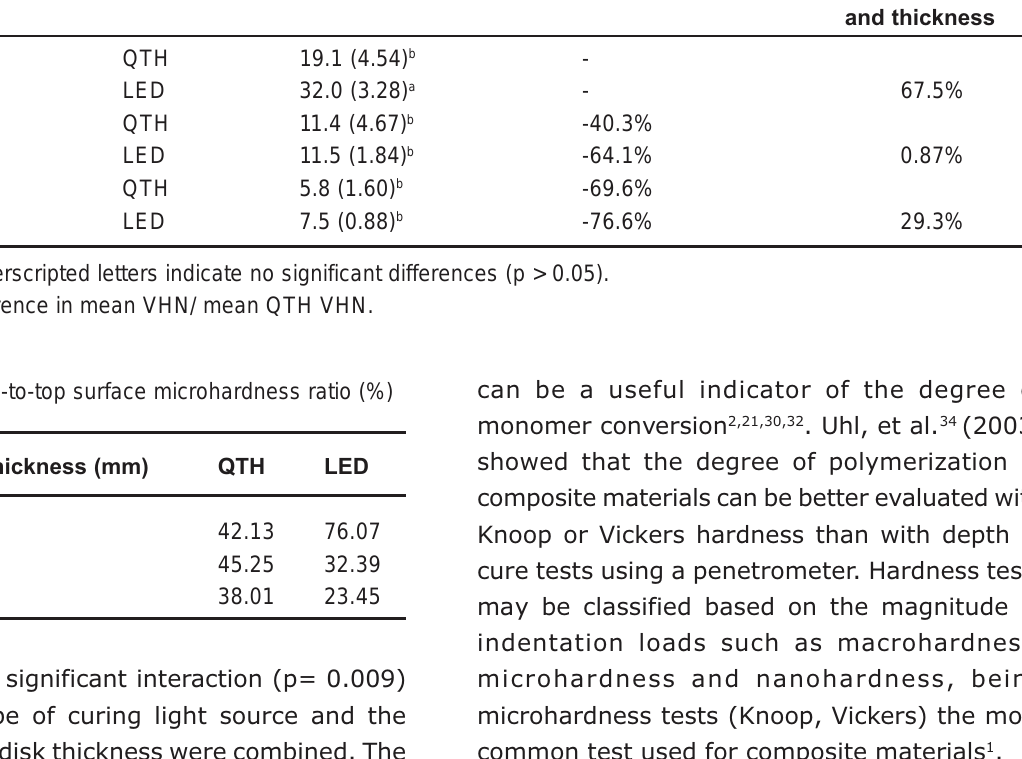
Table 2- Mean hardness values (VHN) (standard deviation) for the bottom surface of the resin cement specimens varying the curing light source and thickness of the indirect resin disks Resin disk